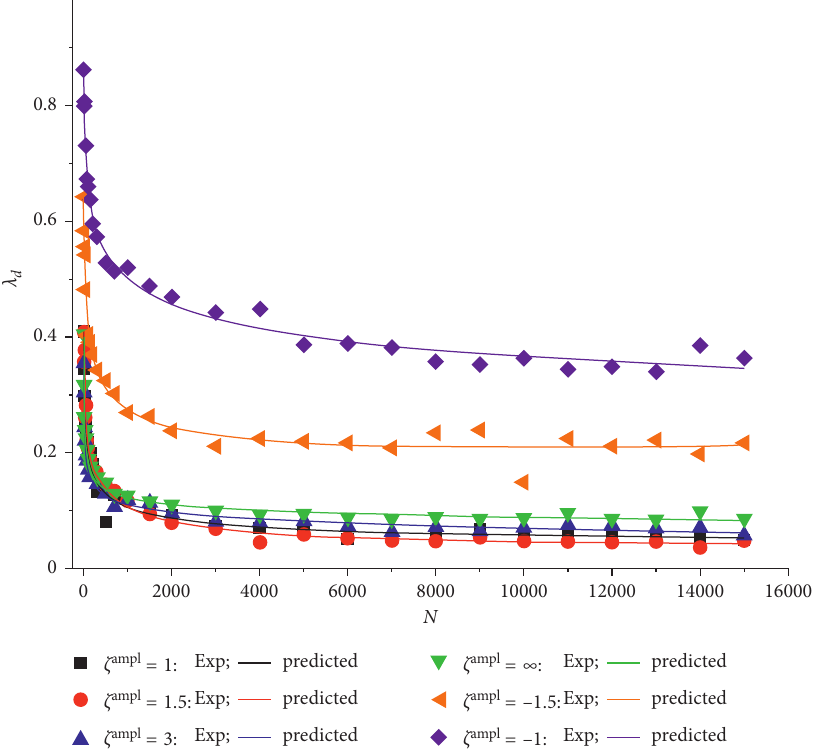
Figure 13: The damping ratios development with an increase in the number of loading cycles under the condition of different dynamic stress paths with the similar deviatoric stress